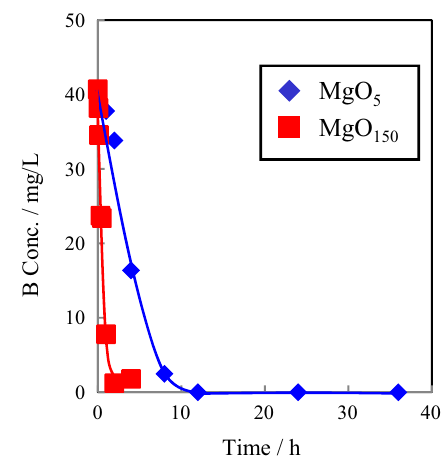
Fig. 5 Changes in boron concentration following treatment of landfill leachate using MgO (Amount of MgO: 1.0 g, 30